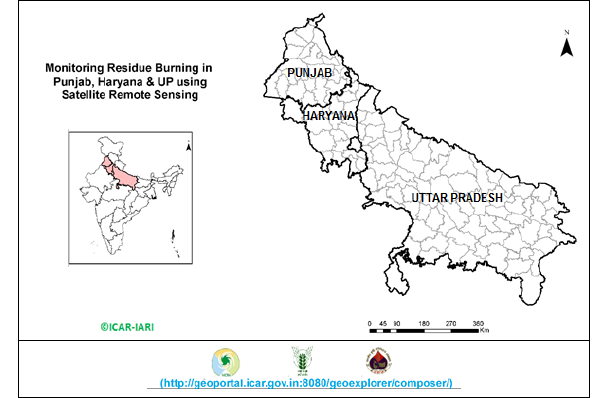
Figure 3. Study area location map depicting Punjab, Haryana and UP states in